Question: Give a one-sentence summary of this figure.
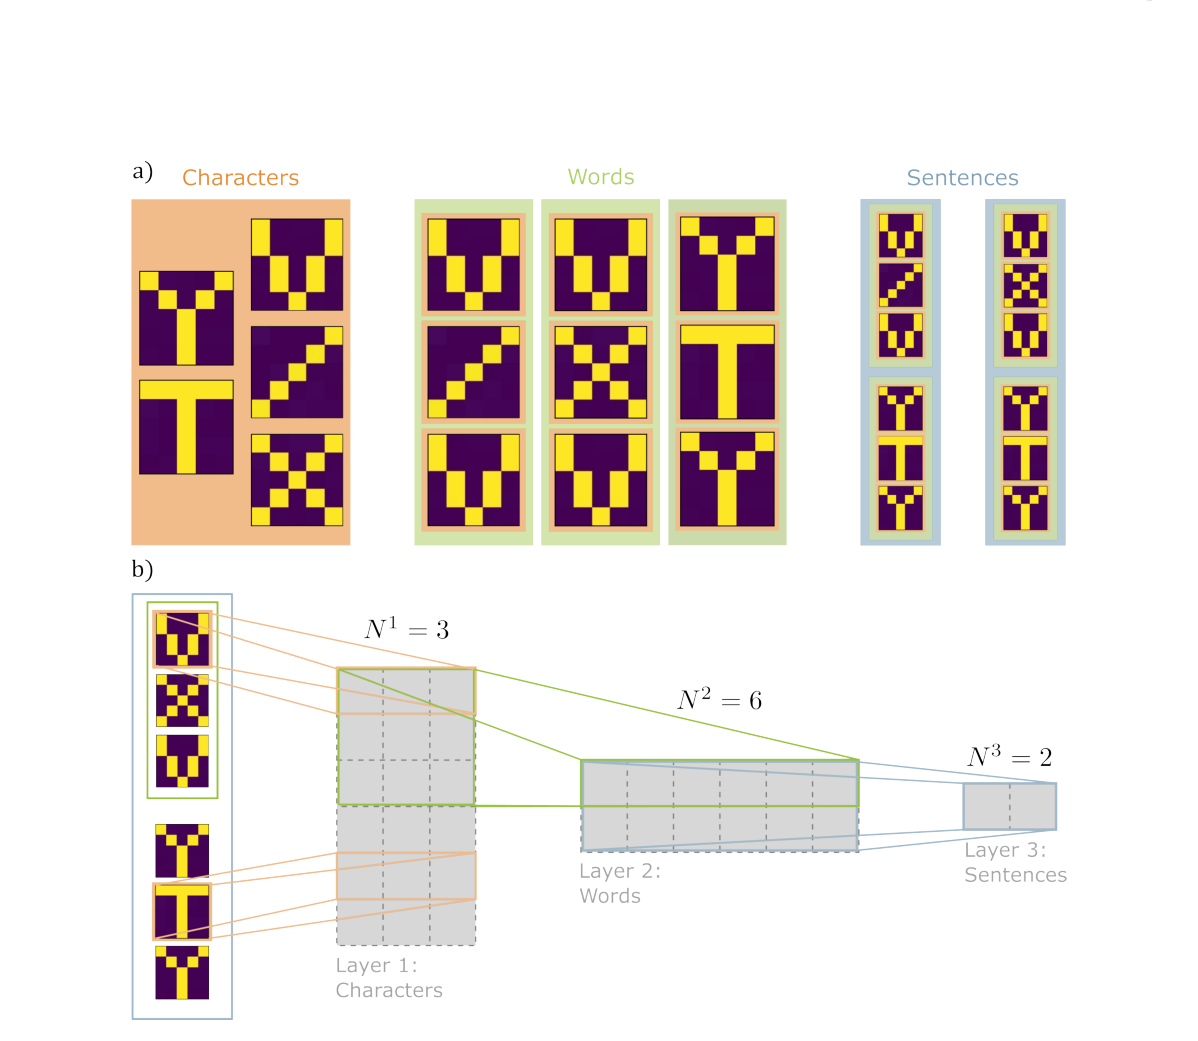
Answer: The visual classification benchmark to test Sup3r on a small 3-layered network. a) The test is composed of a ”sentence” (blue) classification task, where two different sentences are each composed of two among three different ”words” (green), which are composed of three of five different ”characters” (orange). The only difference between the two sentences consists of two characters, ”x” and ”/”, which are contained in the top word. To generate spiking data, sentences are written by a lattice of 5x30 Poisson neurons firing at a high firing rate for the yellow pixels and a low firing rate for the blue pixels. b) The convolutional HOTS network used to solve the task. The gray rectangles represent the output dimensionality of each layer. N is the number of clusters responding to the six different characters in a sentence (Layer 1), to the two words in a sentence (Layer 2), and finally to the entire sentence (Layer 3).